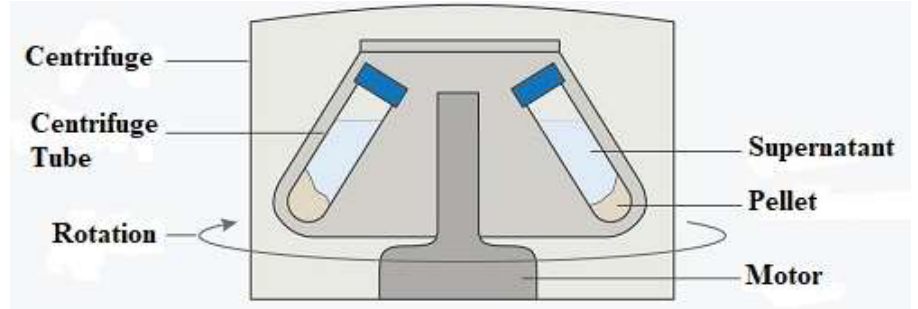
Figure 2. Schematic diagram of the centrifugation process.